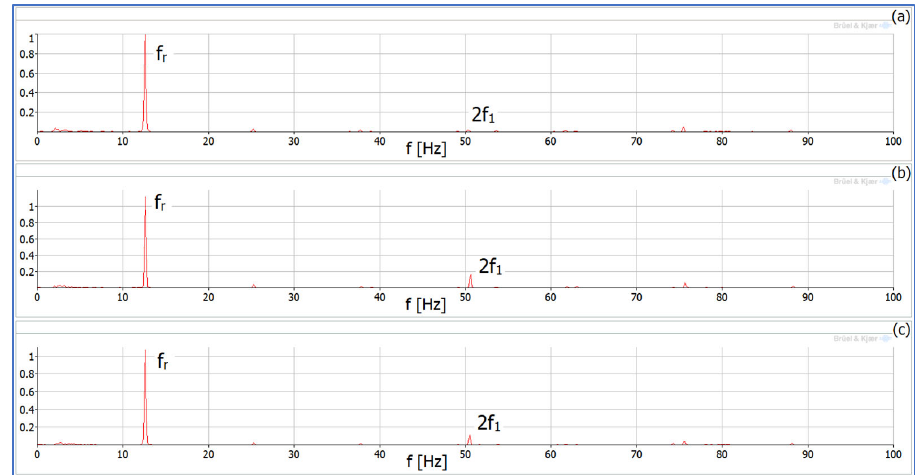
Figure 13. Vibration spectral characteristics for a rotational speed of 750 rpm and no load, where